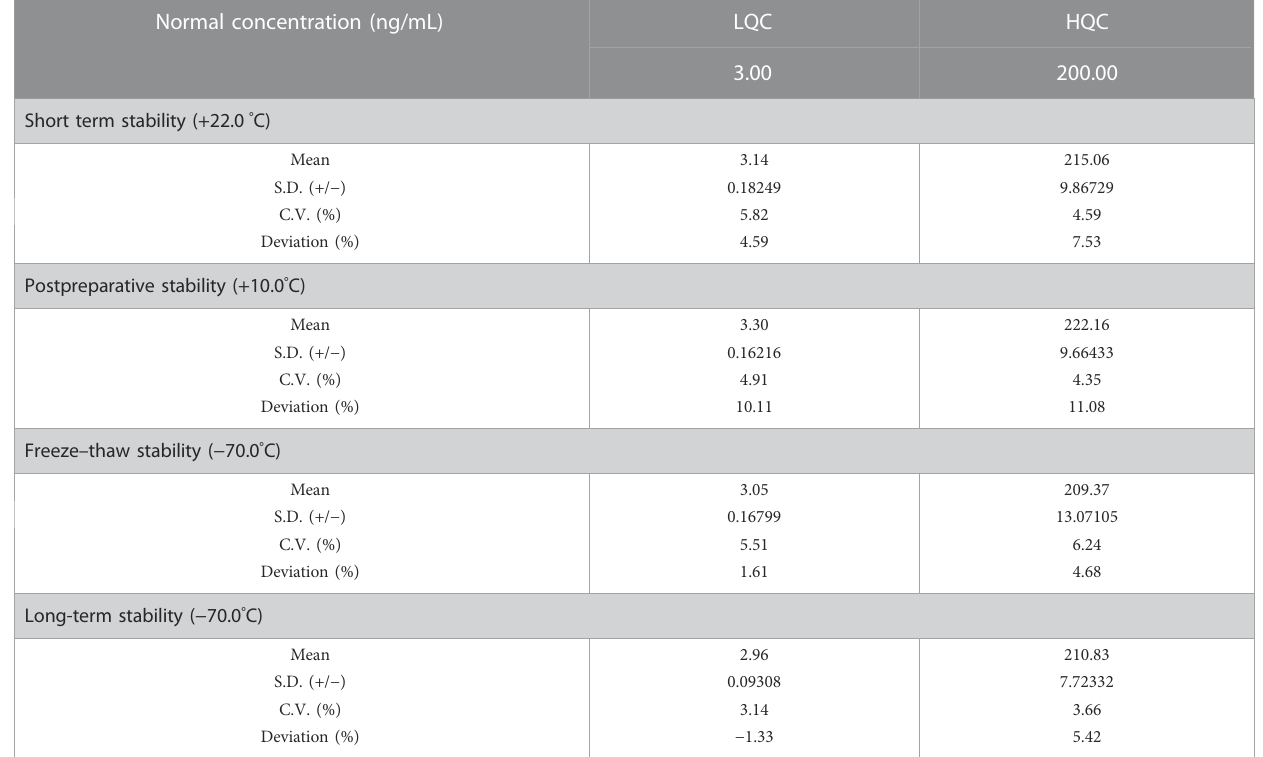
TABLE 3 Stability tests of the 2 9 -hydroxy fl avanone (2HF) in mouse blood under different storage and exposure conditions ( n = 8). Normal concentration (ng/mL)